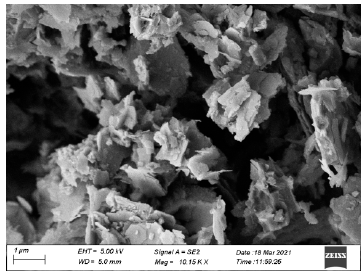
Figure 3. SEM image under 1 μ m scale.